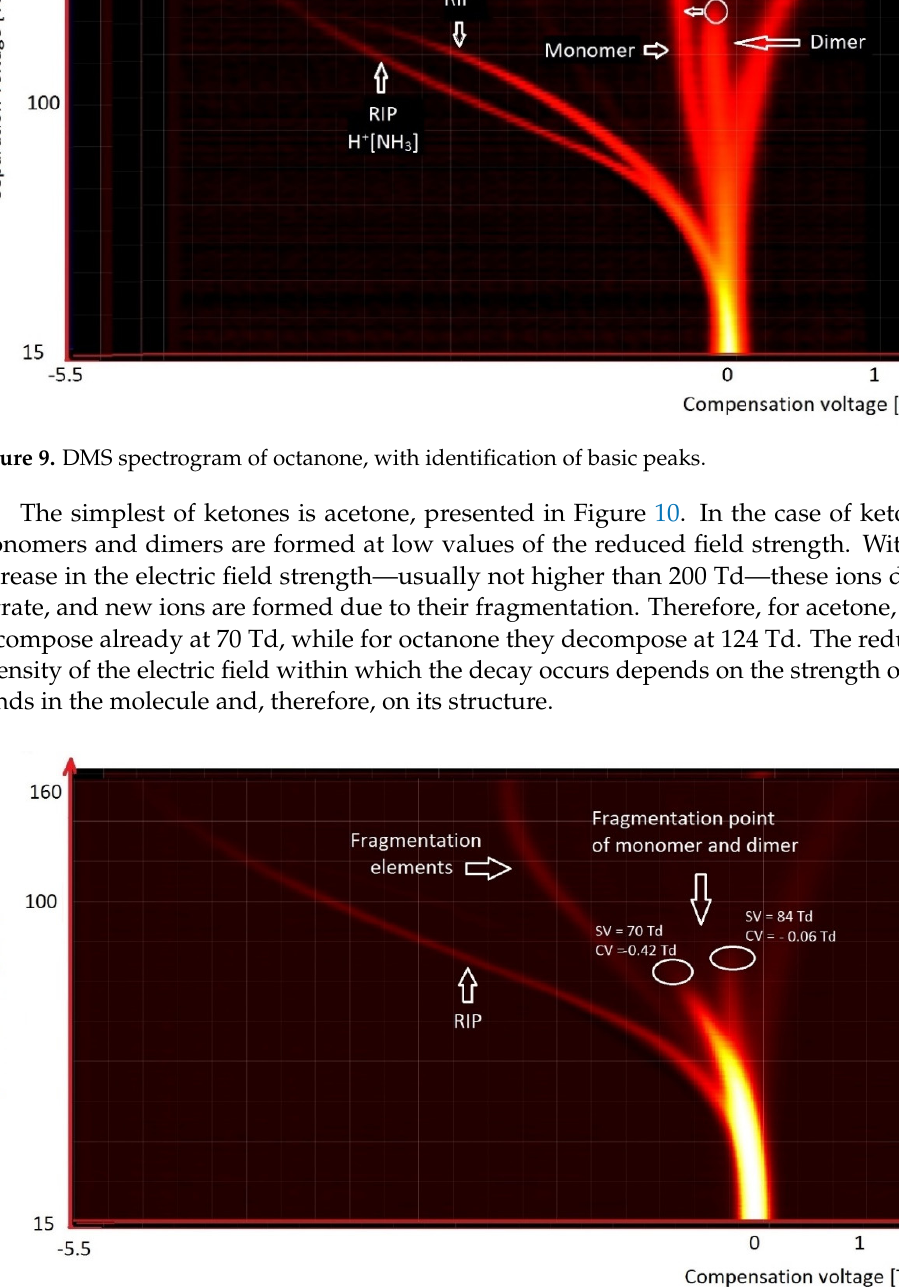
Figure 10. DMS spectrogram of acetone.